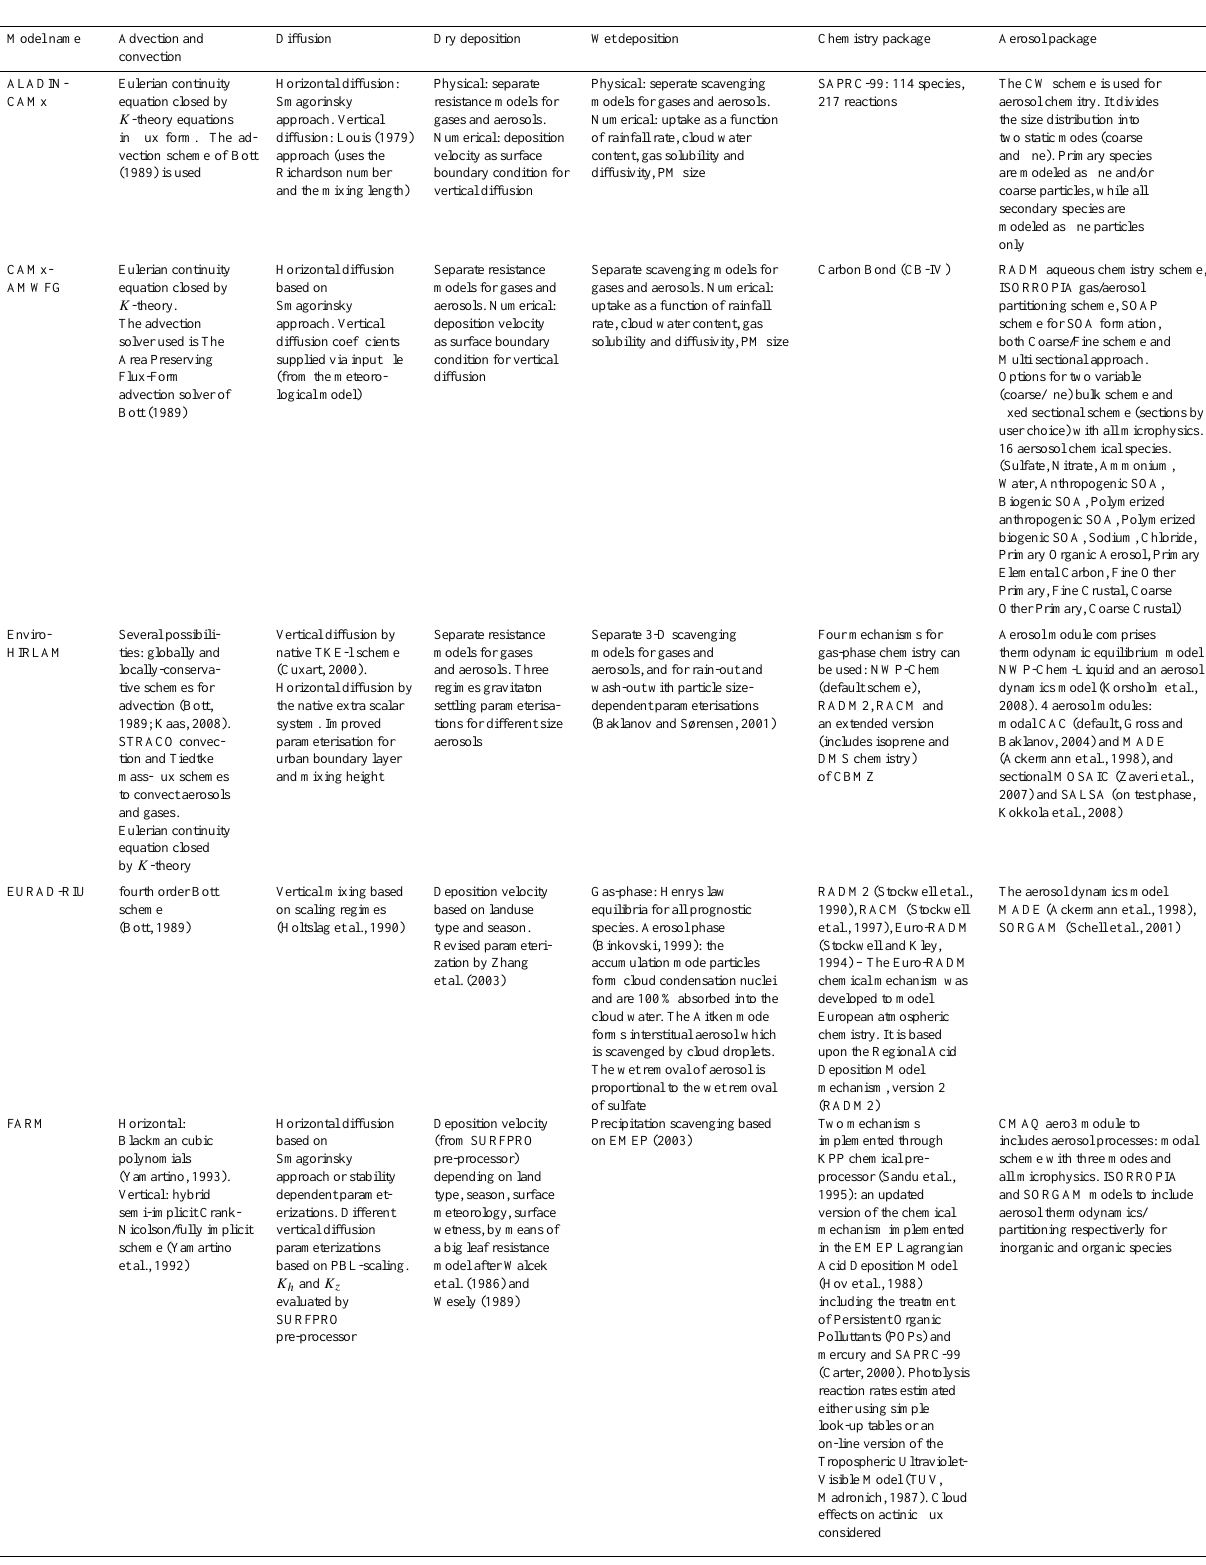
Table 3. Brief characterizations of the main physical and chemical components of the CWF models.